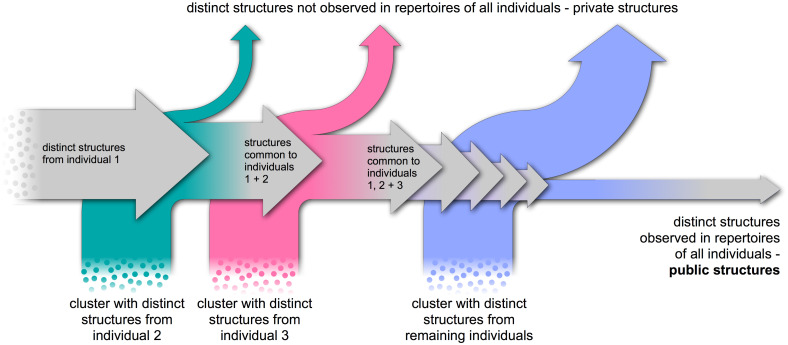
Structural overlap analysis.Datasets are arranged in order of their internal structural diversity (most diverse first). Distinct baseline structures from individual 1 are clustered sequentially with all other repertoire snapshots. Distinct structures present in every tested dataset are classed as ‘public structures’, whereas those that are absent in at least one individual are termed ‘private structures’.